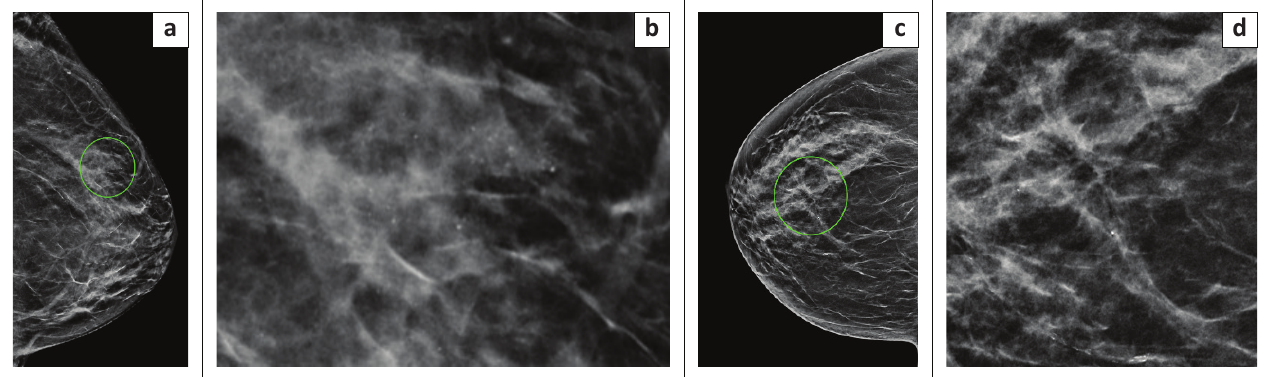
FIGURE 1: Examples of lesions with radiological-pathological discordance based on stereotactic biopsy histology, which were thereafter upgraded. (a) Craniocaudal view and (b) magnified image demonstrating grouped amorphous and pleomorphic microcalcifications in the outer left breast. These were new compared with previous imaging and categorised as breast imaging reporting and data system (BI-RADS) 4c. Stereotactic biopsy yielded benign histology, and this was considered discordant to imaging. Repeat stereotactic biopsy yielded low-grade ductal carcinoma in situ. (c) Right craniocaudal view demonstrating architectural distortion in the central retroareolar region of the right breast. (d) Magnified image showing the associated microcalcifications. This was categorised as BI-RADS 4c. Stereotactic biopsy histology showed benign fibrocystic changes only. Following a multidisciplinary team meeting, a wide-local excision was performed, and histology yielded fat necrosis.